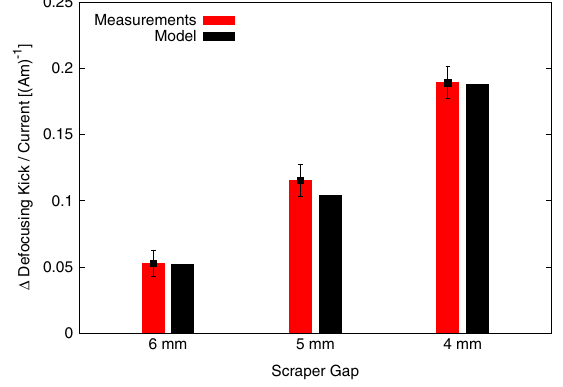
FIG. 6. In red, measured change in the defocusing kick per current unit due to the transverse impedance of the vertical scraper for different gaps with respect to the scraper at nominal position (9.5 mm). Each measurement is obtained averaging over data sets containing 500 acquisitions each. The error bars represent the standard deviation of the estimated focusing kick due to the acquisition to acquisition fluctuations. In black, the predicted values from the impedance computation calculated as kick differences of the considered gap to the nominal scraper gap.